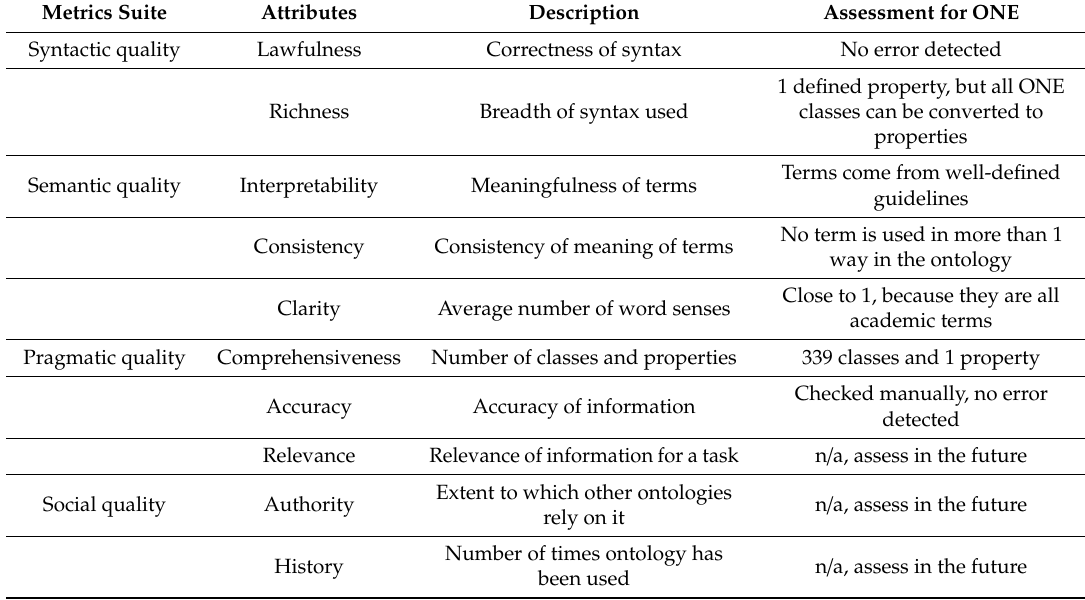
Table A3. Metrics for quality assessment of ONE. n / a—not available.